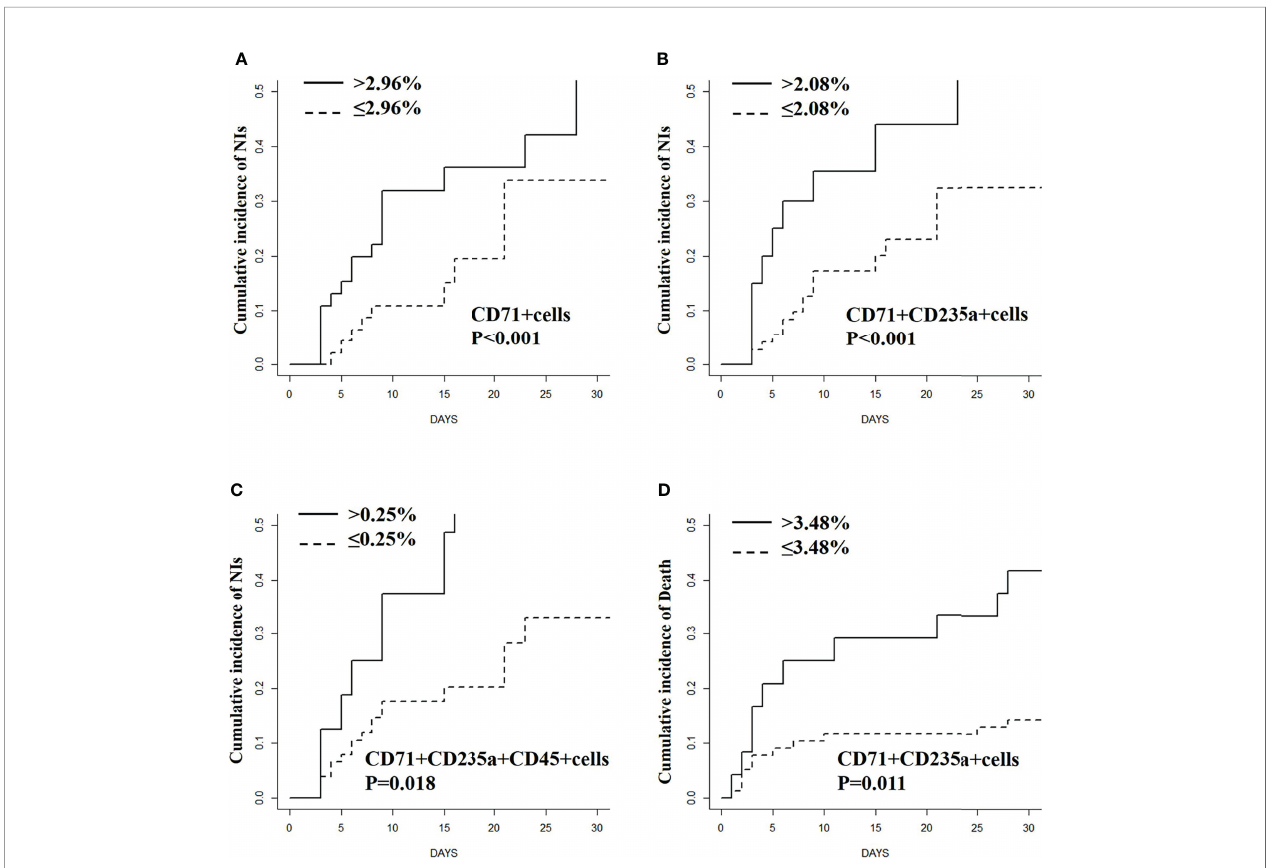
FIGURE 4 | Cumulative incidence curves for nosocomial infections (A – C) and mortality (D) strati fi ed based on the percentage of CD71 + cells and (or) CECs in septic